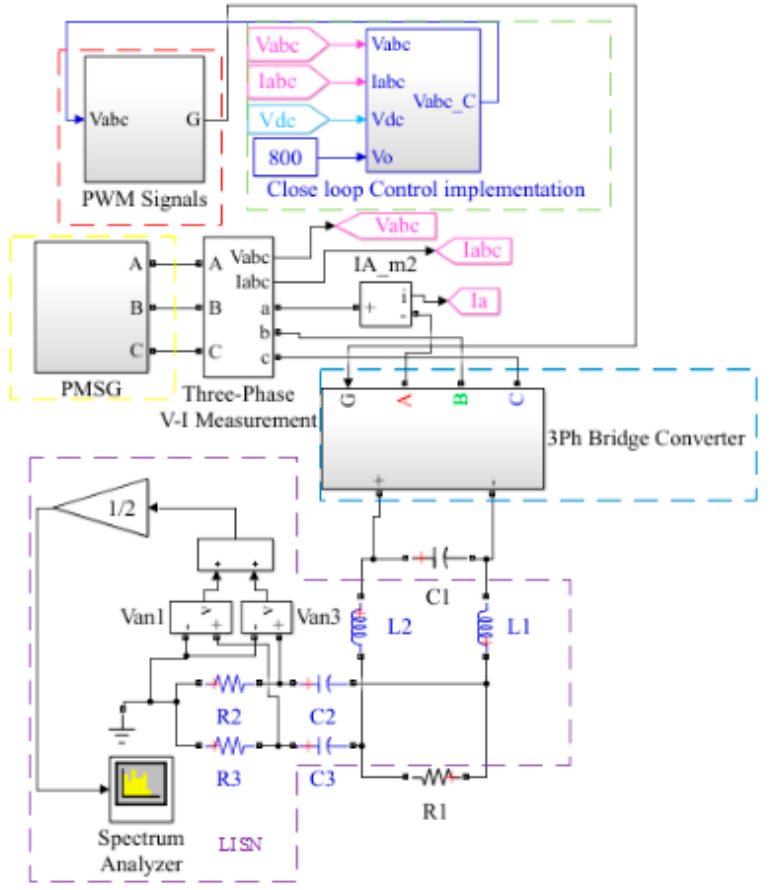
Figure 8. High precision simulation overall model of single module.